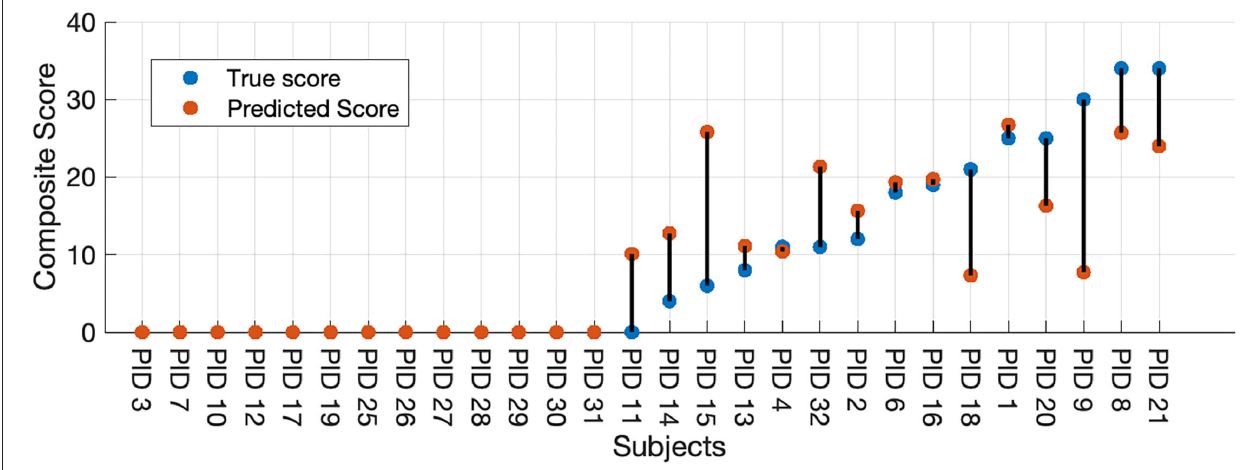
FIGURE 3 | Full-model composite score prediction. Full-model prediction of the composite UHDRS-TMS subscore vs. true subscore for all participants. The composite UHDRS-TMS subscore is a sum of the of the left and right arm rigidity, total chorea, total dystonia, bradykinesia, gait, and tandem gait